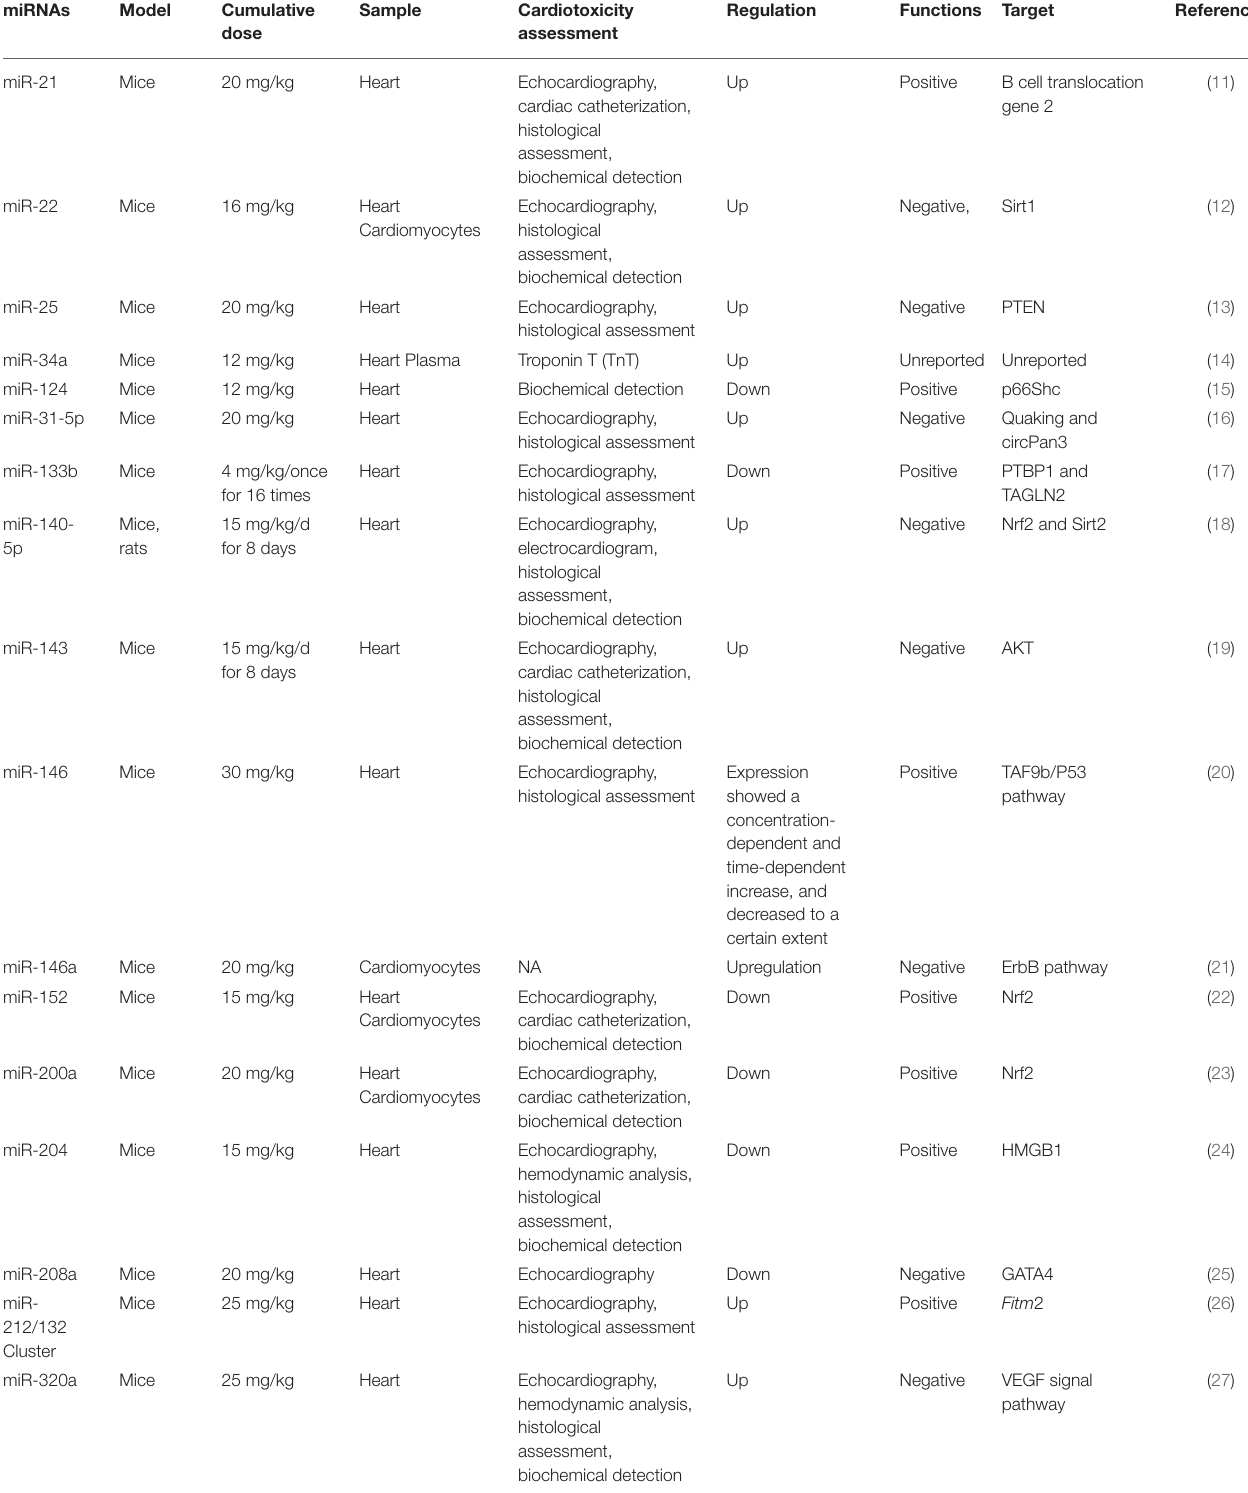
TABLE 1 | miRNAs in DIC development in animal models.